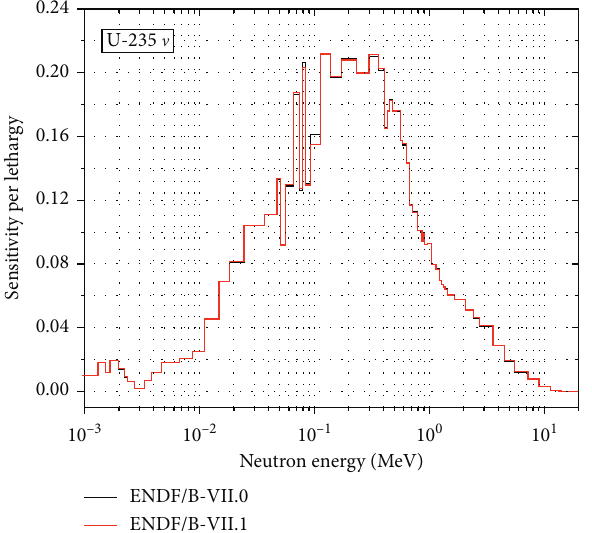
Figure 5: Energy-dependent sensitivities of k section.